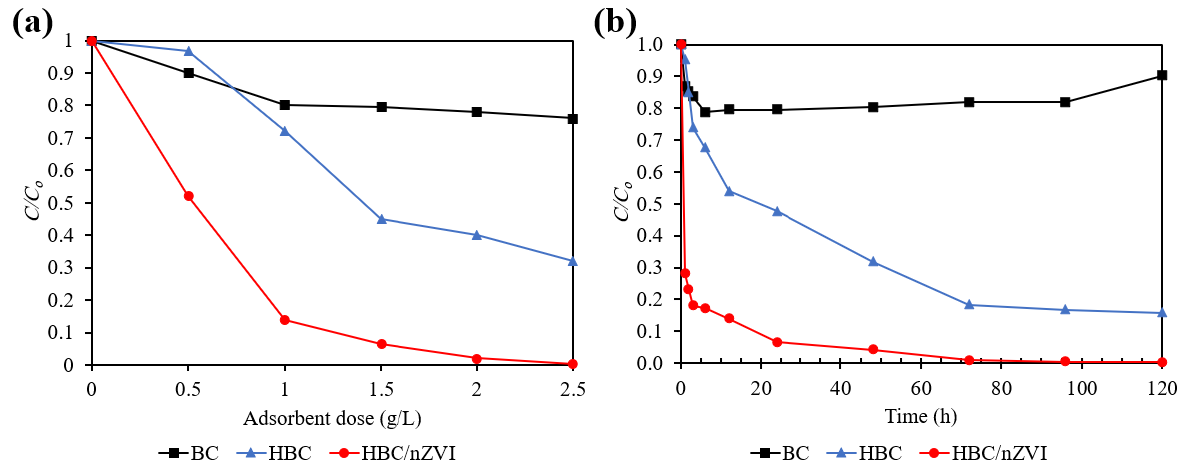
Figure 6. Effects of ( a ) adsorbent dose (initial Cr(V) concentration = 10 mg L − 1 , pH = 4.0, reaction time = 24 h) and ( b ) reaction time (initial Cr(V) concentration = 10 mg L − 1 , pH = 4.0, adsorbent dose = 1.5 g L − 1 ) on the Cr(VI) removal efficiency using BC, HBC, and HBC/nZVI.